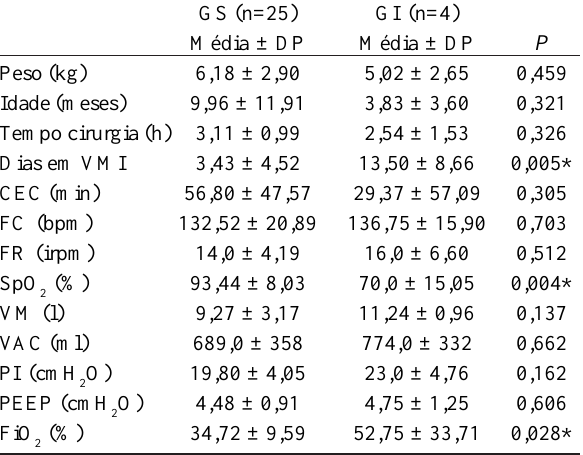
Tabela 2. Variáveis demográficas e clínicas em crianças em pós- operatório de cirurgia cardíaca